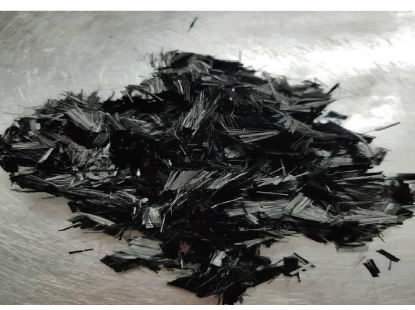
Figure 1: Te carbon fbers used in this study. Table 3: Physical properties of carbon